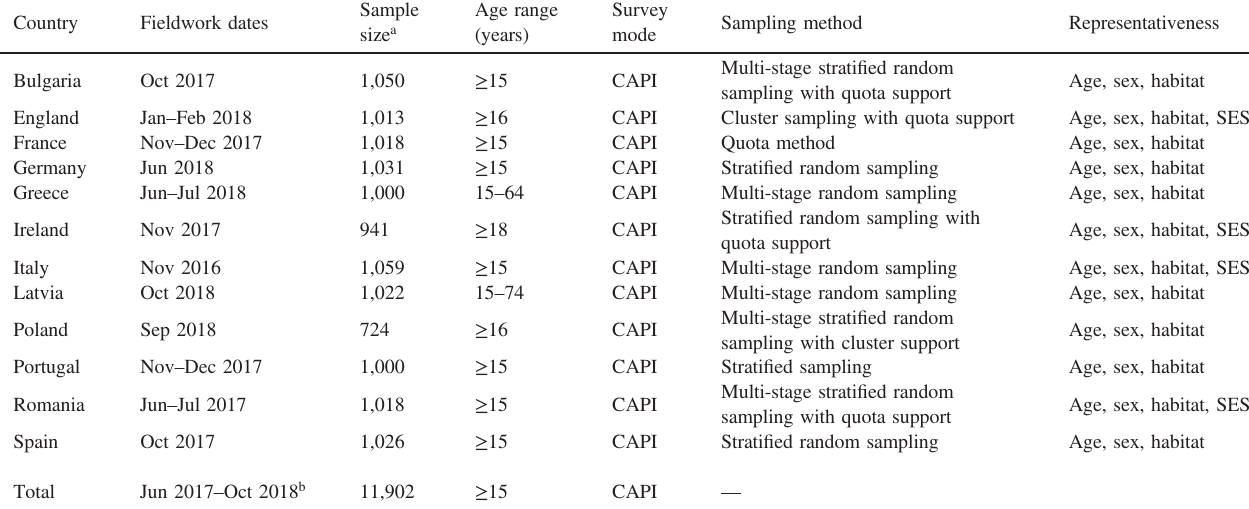
Table 1. Information about survey methods and sample characteristics in 12 European countries. TackSHS Project, 2017 – 2018